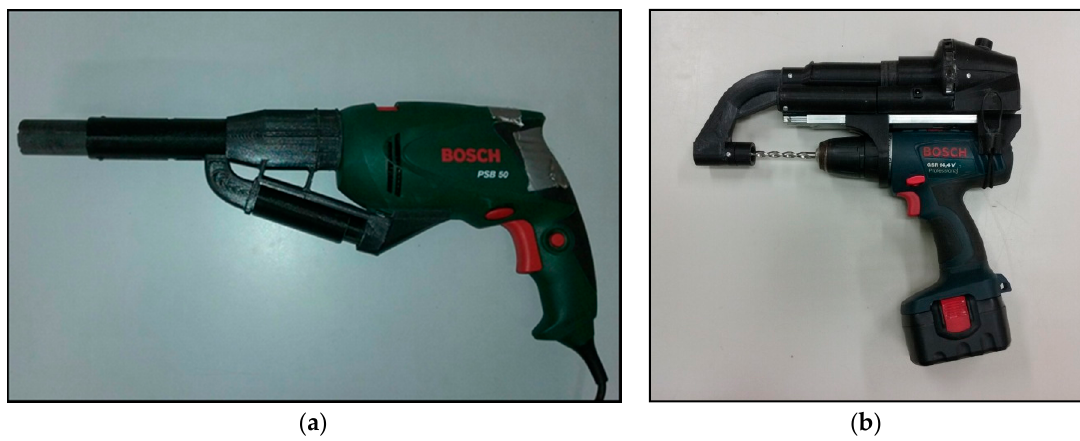
Figure 1. Wood extractor device, ( a ) 8 mm diameter drill bit configuration; ( b ) 7 mm diameter drill bit configuration.